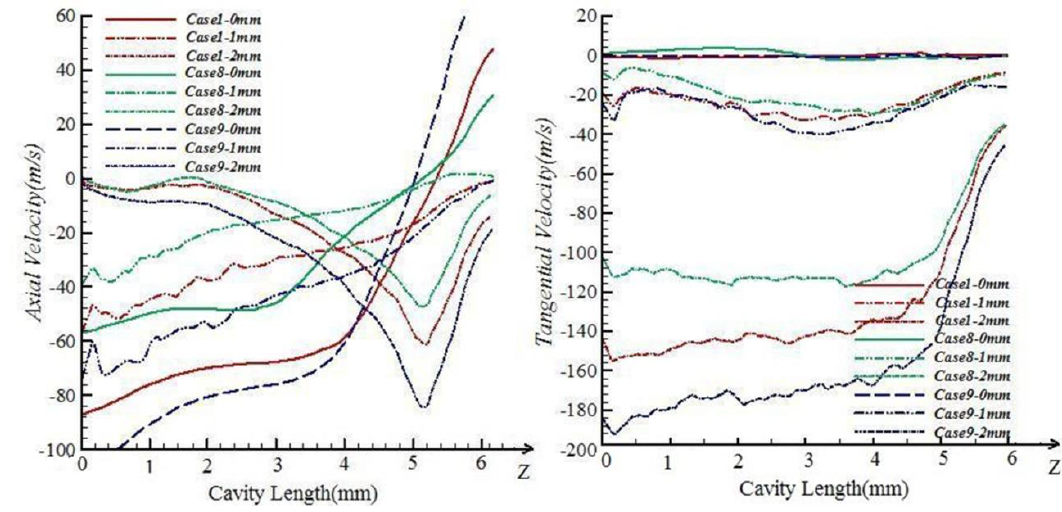
Figure 10. Velocity comparisons among Case1, Case8, and Case9.